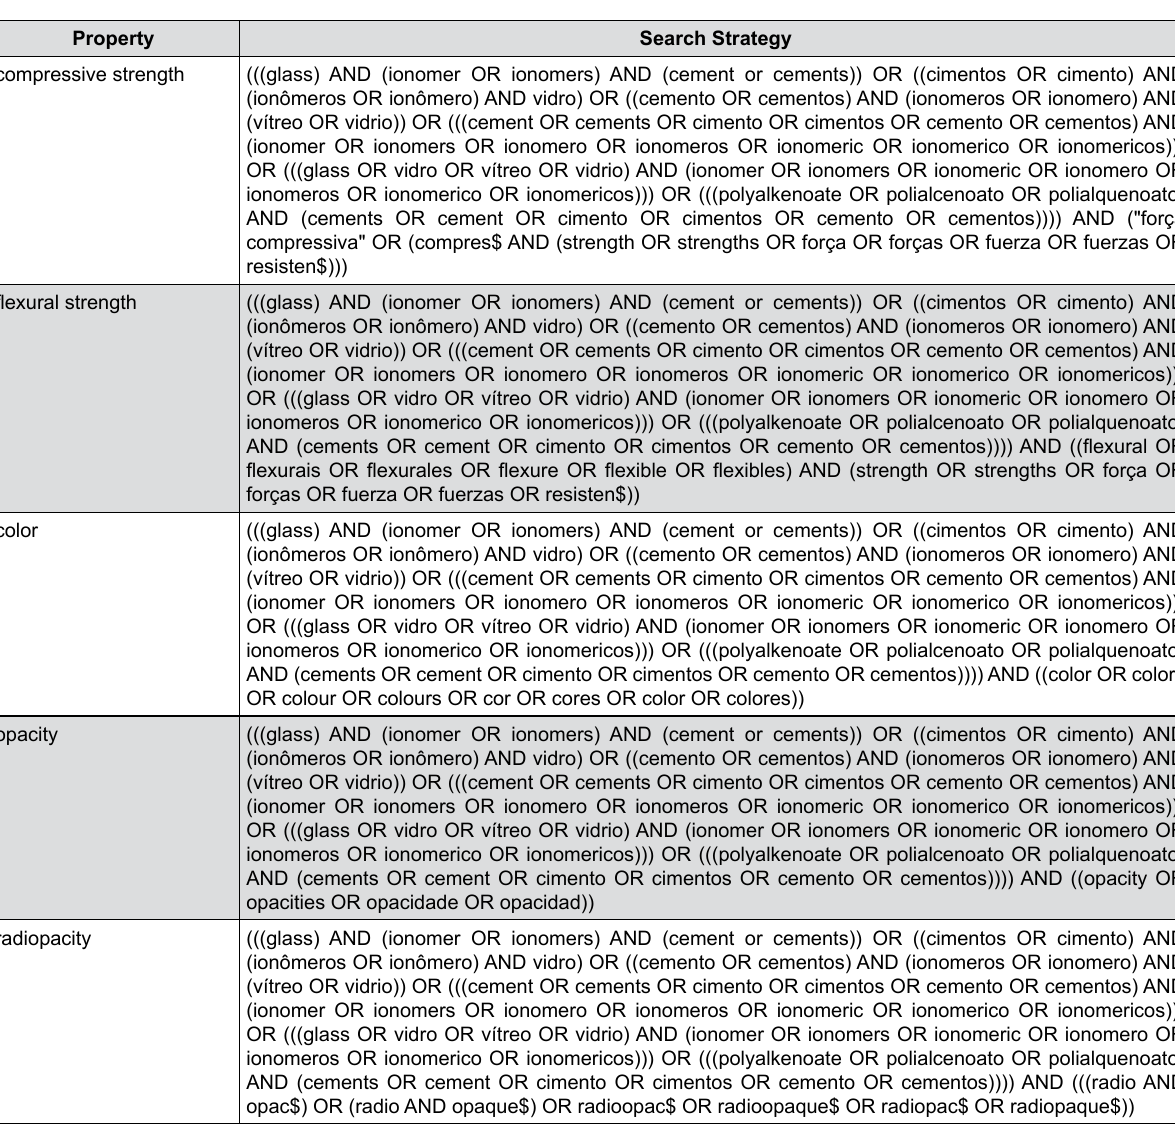
Figure 1- Search Strategy used for LILACS and BBO (Latin-American and Caribbean System on Health Sciences